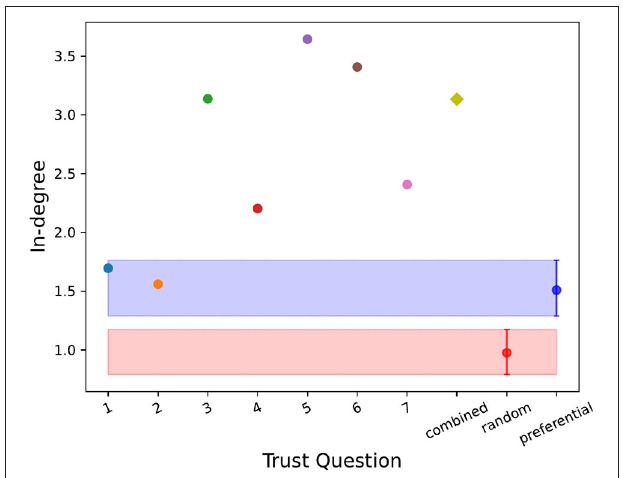
FIGURE 2 | The weighted in-degree for each trust question (i.e., dimension of trust), the combined trust network (yellow diamond) and the random (in red with the mean and 2.5 and 97.5 quantiles around it) and preferential (in blue with the mean and 2.5 and 97.5 quantiles around it) null models. Trust network 1 (vulnerability) and 2 (integrity) showed similar in-degree behavior to the preferential model, however the random model did not perform well as expected.